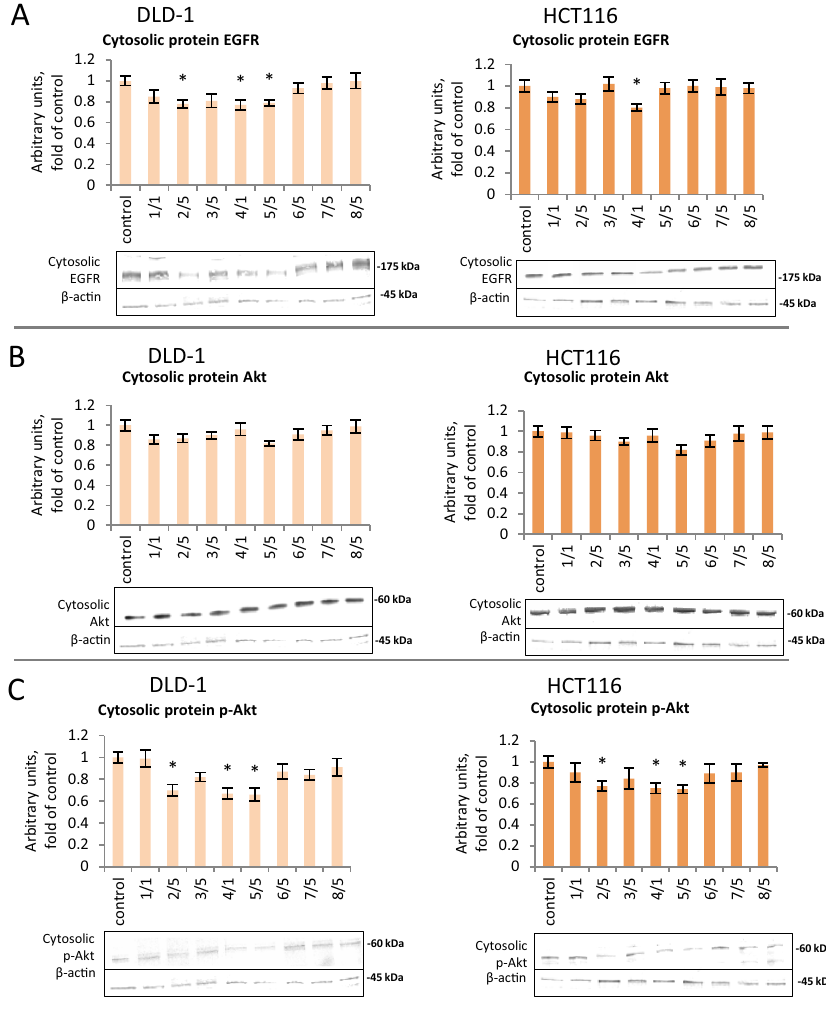
Figure 8. The effect of synthetic thioderivative chalcones compounds on EGFR activation in DLD-1 and HCT116 cells in the cytosolic fraction. ( A) The level of EGFR protein. ( B) The level of Akt protein. ( C) The level of p-Akt protein. Representative Western immunoblots are presented under the graphs ( A–C ). The values (mean ± SEM) were calculated as a relative change in the protein level in comparison with control cells (where control expression equals 1). The values from three separate experiments run in triplicate are presented. Asterisk: mean values were significantly different from the control group (p ≤ 0.05). Original scans of blots are shown in Supplementary Fig.